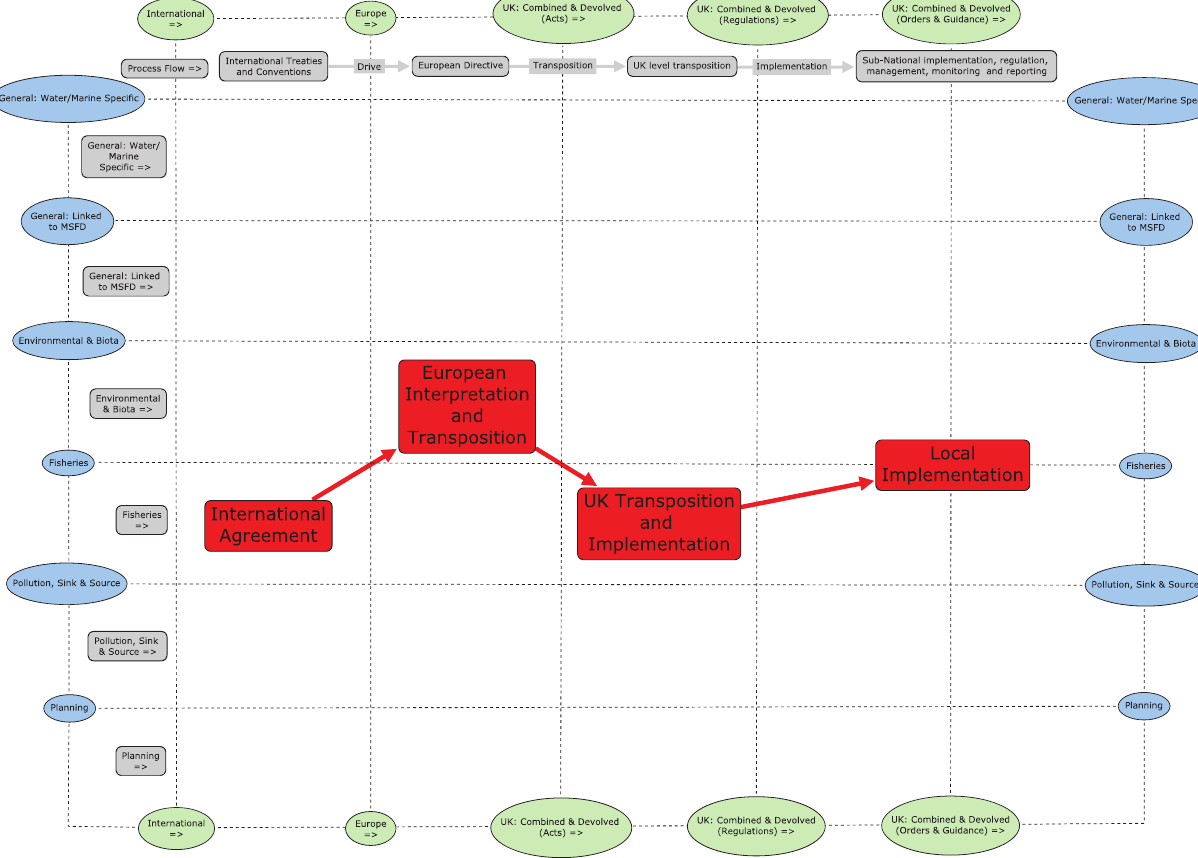
Figure 2. Example of the policy instrument template. In the instrument template the policy process flows from left to right as international objectives are interpreted, transposed and implemented across the policy domains described in the columns. The six categories of policy instruments are aggregated in rows. These instrument categories are: General-water/marine specific; General-linked to directive; Environmental and biota related; fisheries; pollution-source/sink and planning. doi:10.1371/journal.pone.0026149.g002 PLoS ONE |